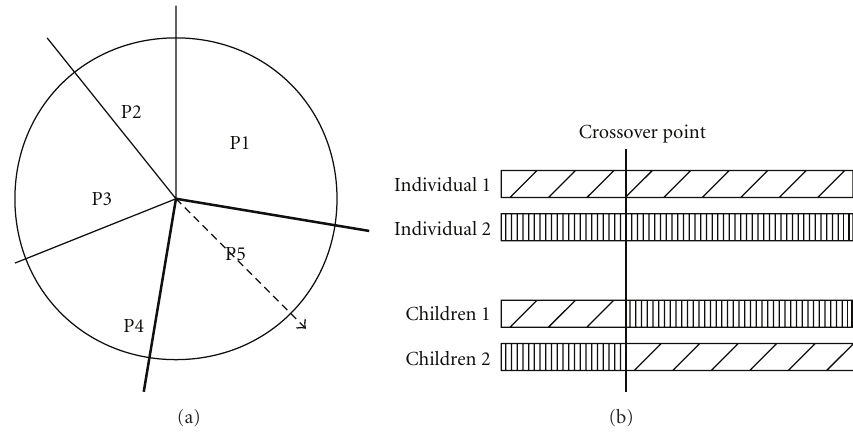
Figure 1: Roulette wheel selection method (a) and crossover strategy